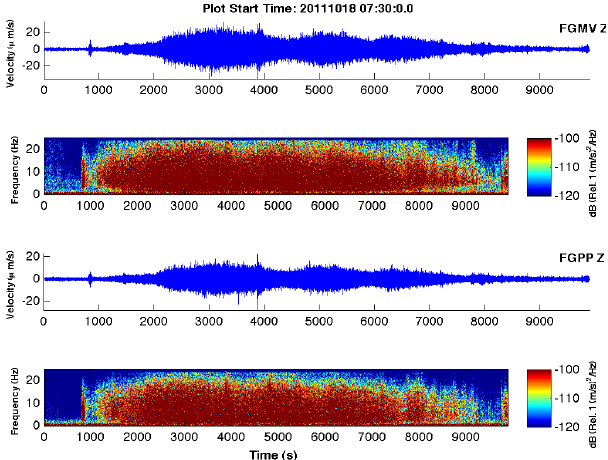
Fig. 6. Example of a cigar-shaped event recorded on Fogo on 18 Oc- tober 2011 at 07:30UTC. Seismogram and spectrogram of the verti- cal component of the stations FGMV (top) and FGPP (bottom). The spectrograms were computed by means of the Welch method using windows of 10.24s, with 50% overlap and tapered by a Hanning window also of the same size.